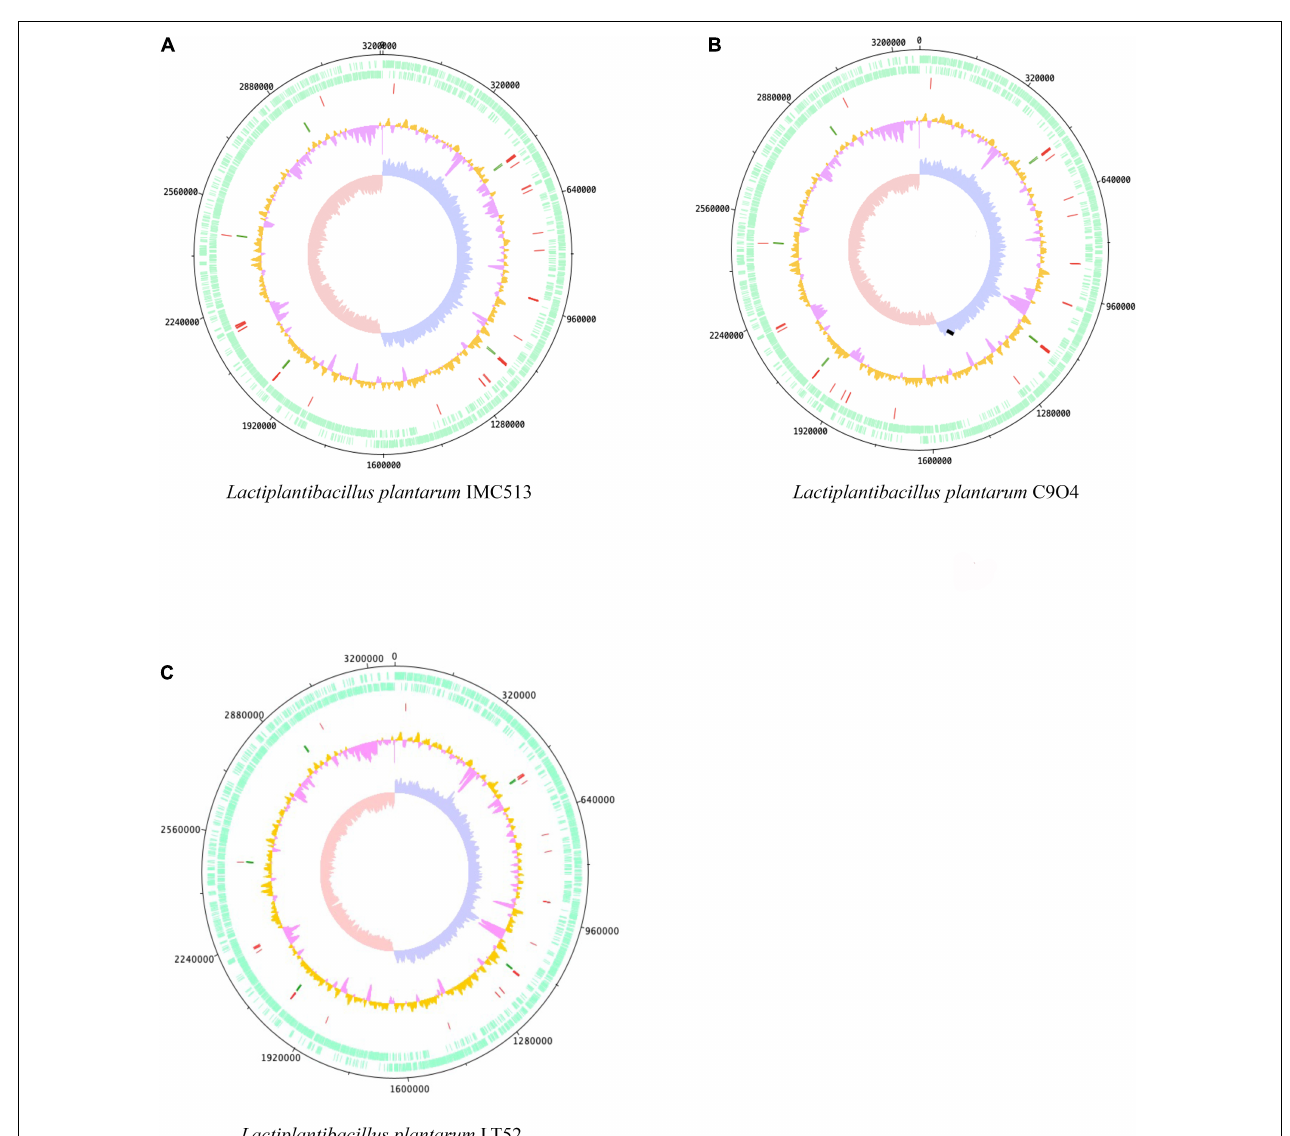
FIGURE 1 | Genome atlases of the three Lactiplantibacillus (Lpb.) plantarum strains. (A) Lpb. plantarum IMC513, (B) Lpb. plantarum C9O4, (C) Lpb. plantarum LT52. The three figures are organized from outer to inner circles, circles indicate (i) CDS (+, forward strand), (ii) CDS (–, backward strand), (iii) tRNA (red), (iv) rRNA (green), (v) GC content (orange and pink), and (vi) GC skew (leading strand blue and lagging strand red). TABLE 2 | Comparison of chromosomal properties of Lactiplantibacillus(Lpb.) plantarum strains. Strains Genome size